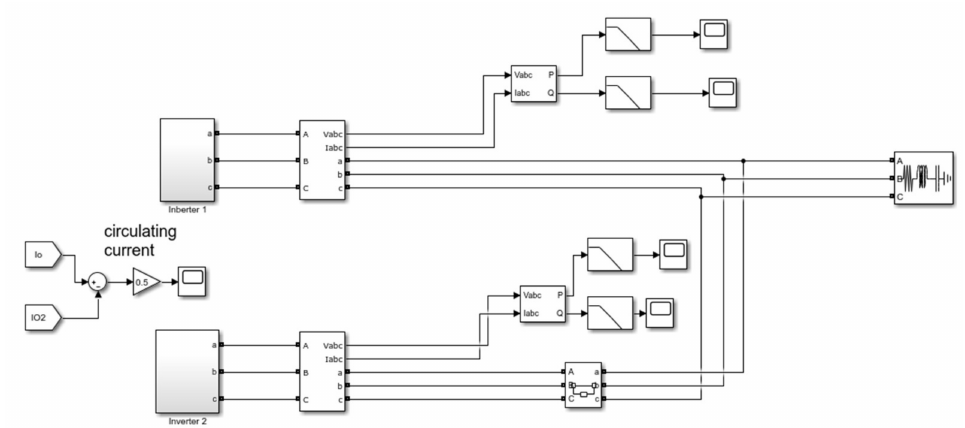
Figure 8. The Matlab Simulink model.